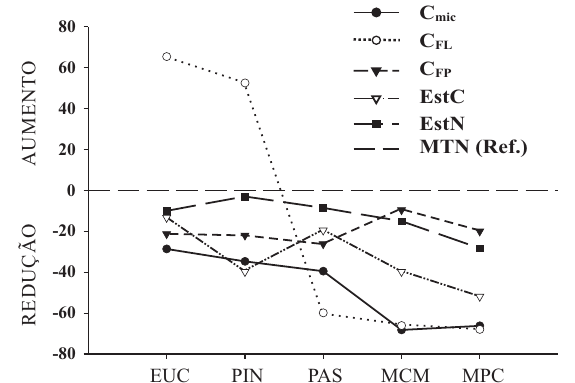
Figura 3. Atributos de Latossolo Vermelho distroférrico típico nos sistemas eucalipto (EUC), pinus (PIN), pastagem (PAS), milho no sistema de cultivo mínimo (MCM) e milho no sistema plantio convencional (MPC), em comparação ao sistema mata nativa (MTN). : Cmic: carbono da biomassa microbiana, C FL carbono associado à fração leve; C : carbono FP associado à fração pesada (C-areia + C-silte + C- argila); EstC: estoque de CO; EstN: estoque de NT. Os dados de EstC e EstN foram obtidos das amostras coletadas na profundidade de 0–10 cm; os dados dos demais atributos referem-se às amostras da profundidade de 0–5 cm. Aumento ou redução em relação ao sistema